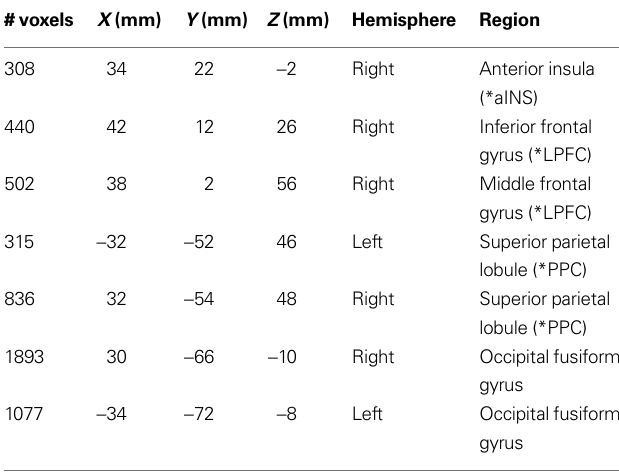
Coordinates indicate the centroid of the activation within each anatomical region. Voxels are 2 mm 3 . *Indicates functional label used in